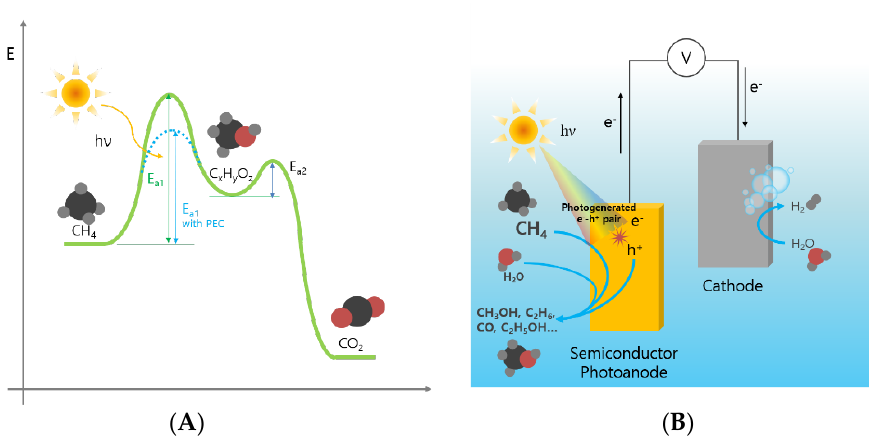
Figure 3. Schematic energy diagram of methane oxidation with a photocatalyst ( A ) and photoelec- trochemical system ( B ).